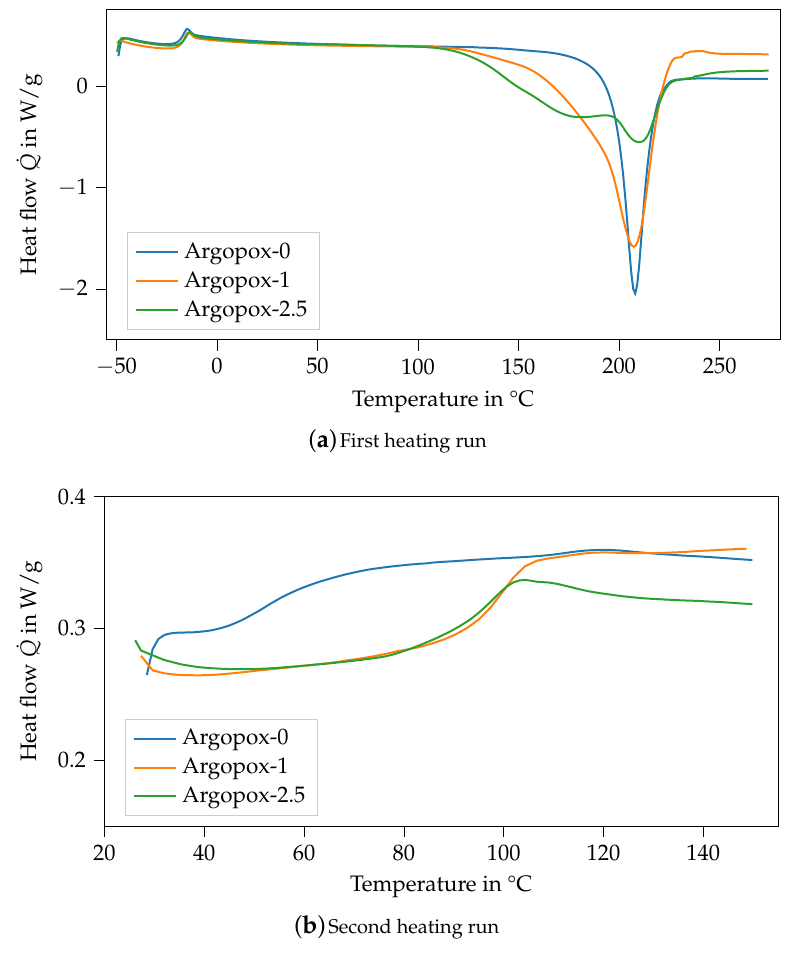
Figure 4. DSC thermograms of the mixture of DGEBA and L -arginine without any accelerator (Argopox-0, blue) as well as with 1wt.% (orange) and 2.5wt.% (green) of DYHARD®UR500 of the first ( a ) and second ( b ) heating